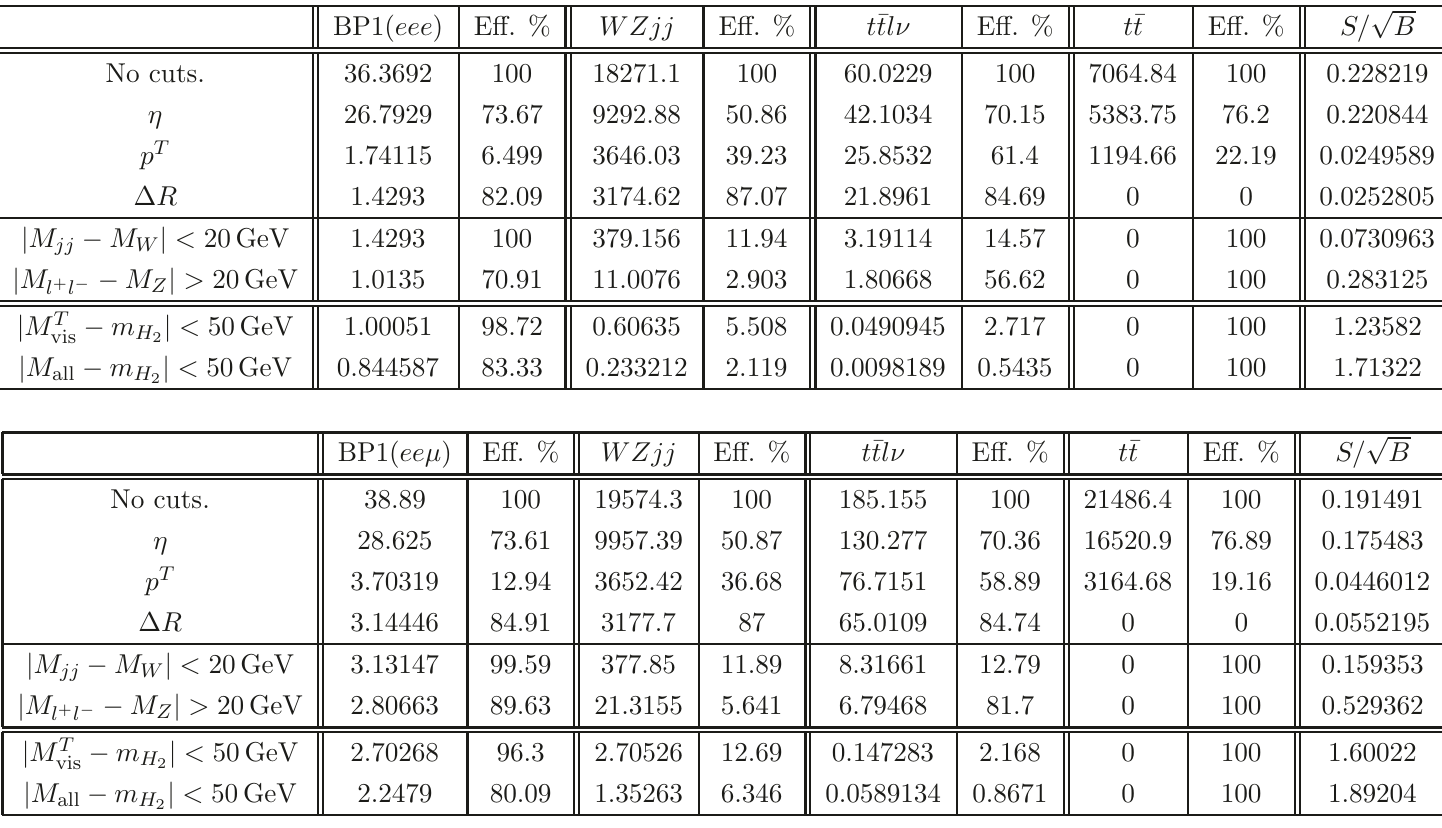
= 100fb − 1 . Universal acceptance cuts = L > 10 GeV. Notice that here and in all the following tables, 0 events means the estimated value is less > 14GeV and p T µ e 1 , 2